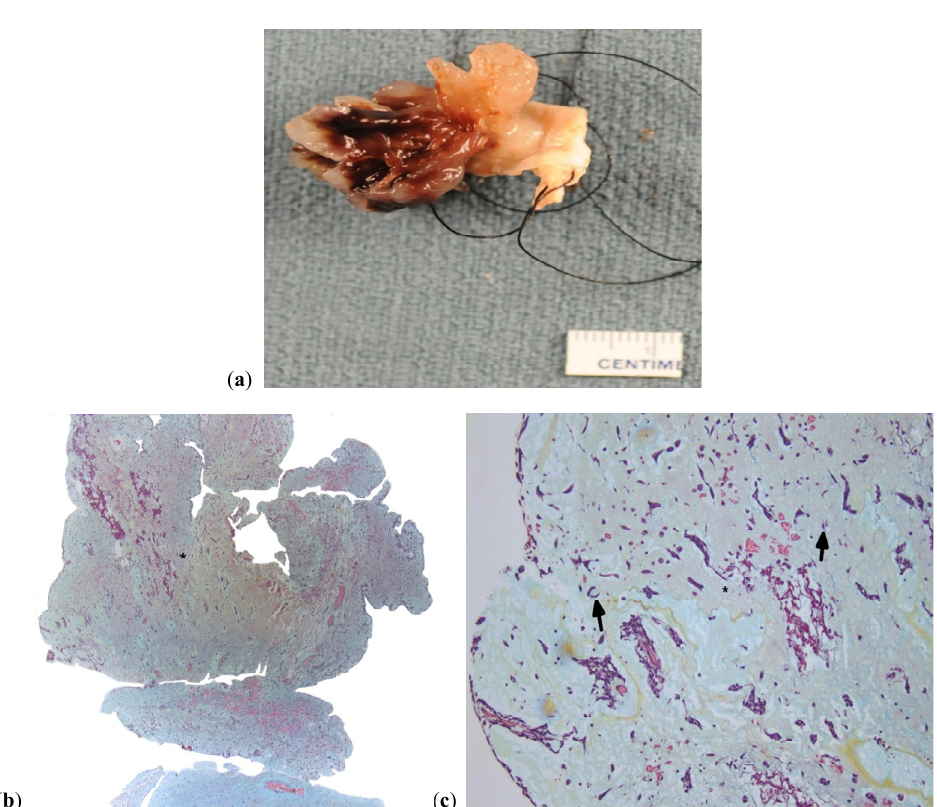
Figure 2. ( a ) Gross picture of a soft myxoma with multiple finger-like projections; ( b ) Histologic section shows a soft friable myxoma (asterisks) with multiple villous projections; ( c ) Higher magnification of the same showing stellate lepidic cells (black arrow) in a myxoid background (asterisks). (( b , c ) Stain: Movat pentachrome; Original magnification ( b ) ×1.2; ( c )